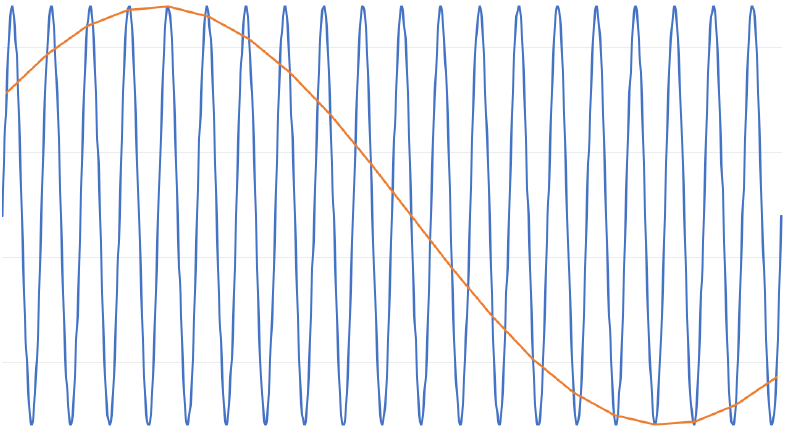
Figure 3. Aliasing effect shown on a 50 Hz sine